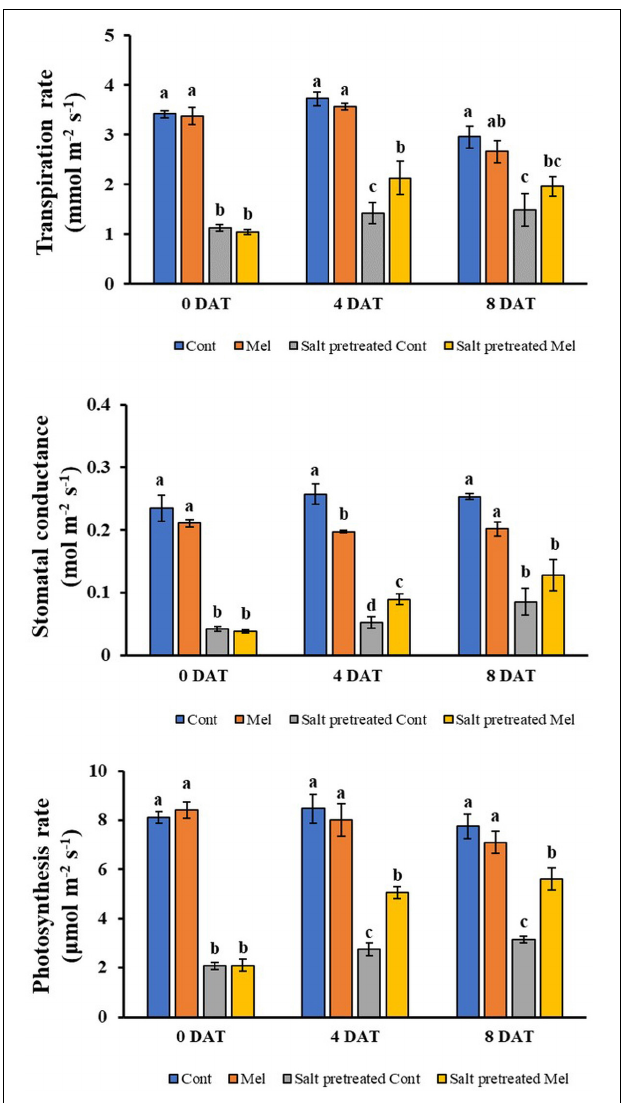
FIGURE 5 | Effect of melatonin with/without salt stress on photosynthetic parameters in green mustard seedlings. The results were calculated from data for 4 (4DAT) and 8 (8DAT) days. Treatment: control + water, control + 1 µ M melatonin, 150 mM salt pre-treatment + water, 150 mM salt pre-treatment + 1 µ M melatonin. Values show the means ± SE ( n = 3). Letters represent significant differences at p < 0.05 in accordance with Duncan’s multiple range tests.